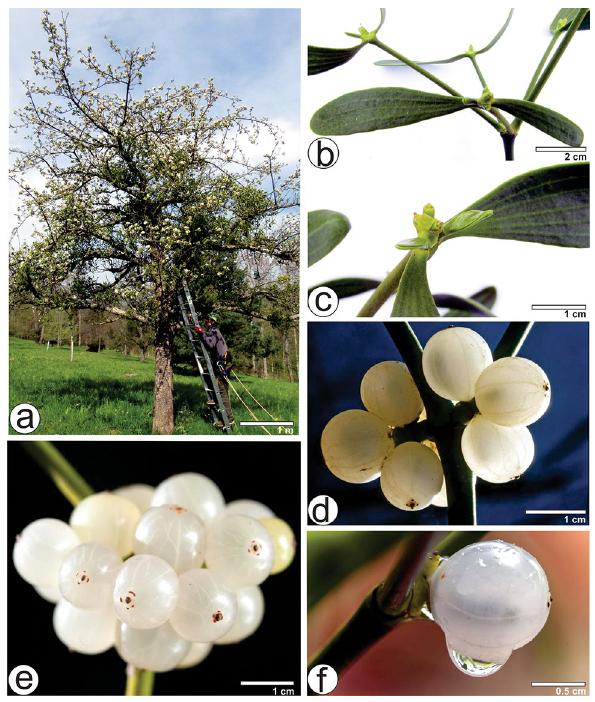
Figure 1. Morphology of Viscum album subsp. album . ( a ) Plants growing on host branches of Malus domestica . ( b ) Several shoots originate from the same node. ( c ) Stem with two opposite leaves. ( d ) Berries. ( e ) Infructescence with berries showing terminal ring of four lateral (tepalar) and one central (stigmal) scars. ( f ) Berry with a